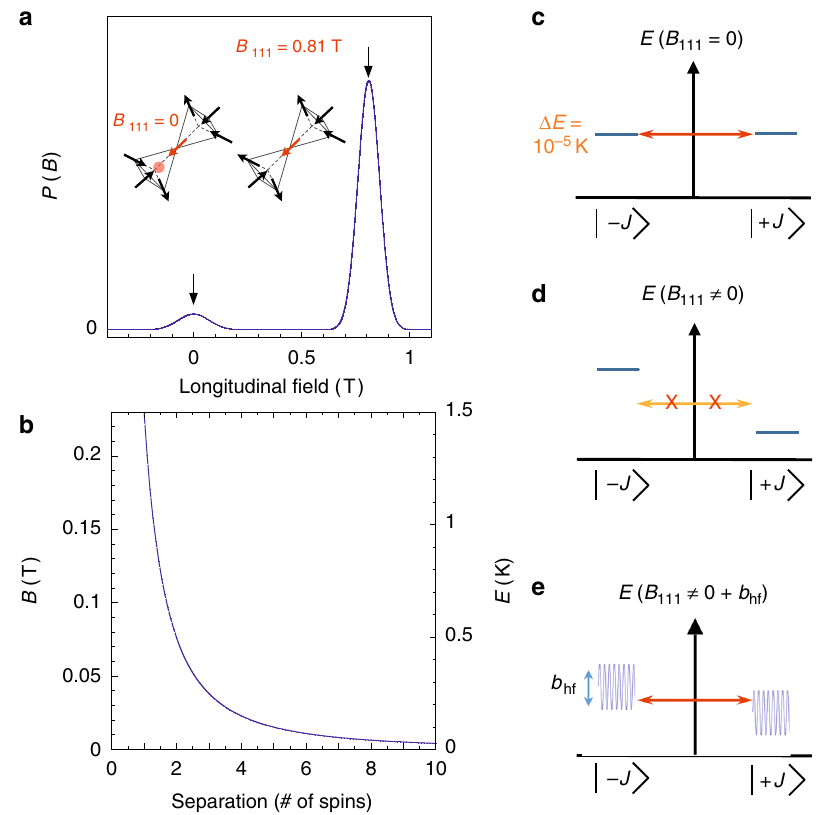
Fig. 1 How magnetic monopoles tunnel in spin ice. A magnetic monopole is a many-body state that moves via the dynamics of local fl ippable spins. a A qualitative schematic of the longitudinal fi eld distribution ( P ( B )) around a central fl ippable spin (red), showing how the distribution is centred around zero fi eld ( B = 0 T) when there is local monopole (red sphere), and centred around 0.81 T when there is no monopole, which is the case for the vast majority of spins at the millikelvin temperatures discussed here. (Note that (i) the 0 T peak is greatly exaggerated to show on the same scale as the 0.81 T peak; (ii) 0.81 T represents the true fi eld for Dy 2 Ti 2 O 7 — including antiferromagnetic exchange reduces the molecular fi eld to about 0.43 T). The broadening of the distribution arises in part from the presence of monopoles and in part from the fi nite energy spread of Pauling states. b The longitudinal fi eld and energy cost of a monopole hop for an isolated monopole – antimonopole pair as a function of the distance between them. c The resonant tunnelling process of a fl ippable spin associated with a monopole; a longitudinal fi eld less than the tunnel splitting for an isolated spin, Δ E ≈ 10 − 5 K 14 , will allow tunnelling transitions between the plus and minus spin states. d A schematic showing how monopole fi elds can take the fl ippable spins off-resonance, such that tunnelling is suppressed. e If the spins are not too far off the resonance condition, then rapidly varying hyper fi ne fi elds b hf from the precession of nuclear moments can bring otherwise blocked spins into resonance and thus relaxation continues by